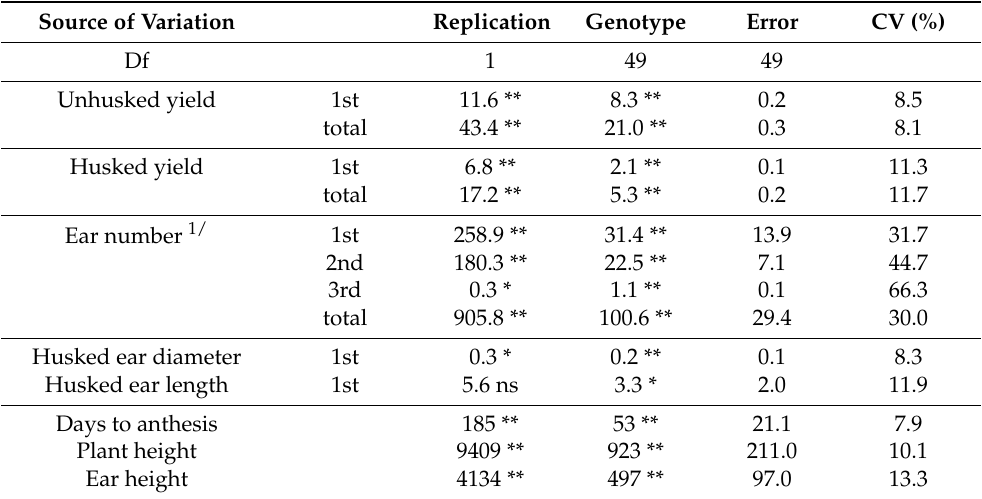
Table 2. Mean squares for yield, yield components, and agronomic traits of 50 orange small-ear waxy corn genotypes in the rainy season